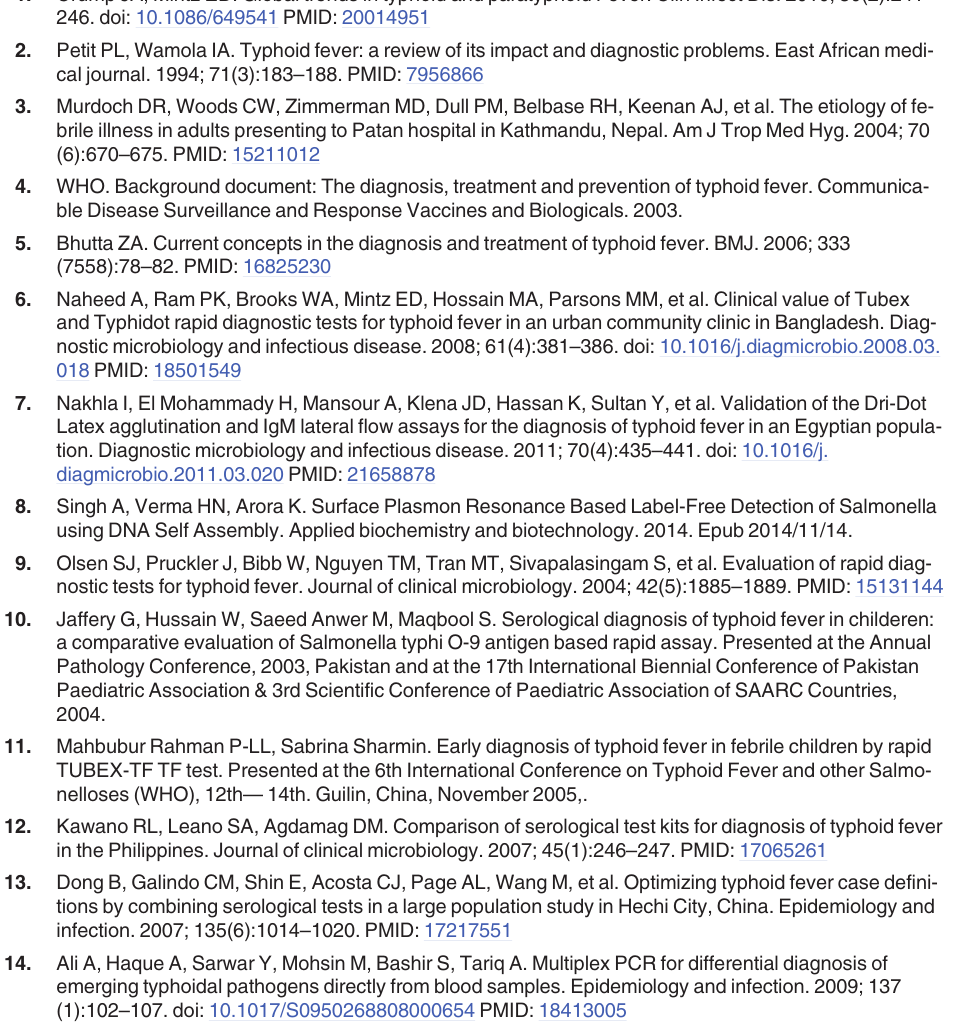
S1 Fig. The growth curves of the simulated blood samples with 10 – 1 CFU / mL of S . Typhi. The simulated blood samples was injected into each 40 mL blood culture bottle (BD BACTEC lytic/ 10 Anaerobic/F culture Vials) to make the final culture with 10 – 1 CFU / mL of S . Typhi and incubated at 37°C for 14 h. Throughout the enrichment process, the growth curve was plotted by counting the bacteria number and determining the concentration of bacteria at every hour.